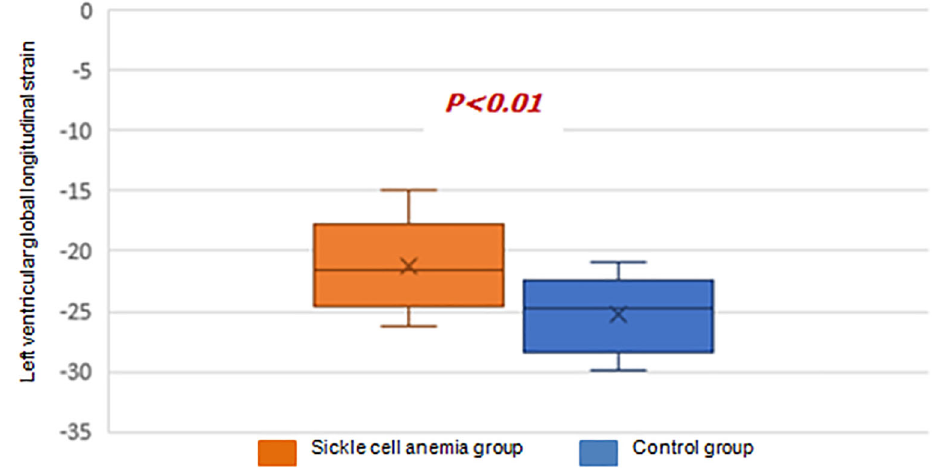
Figure 4. Comparison of the left ventricular global longitudinal strain in the two (cid:129) Study of longitudinal myocardial deformation using the speckle tracking technique Accordingtothisstudy,theoptimal cutoffvalueofGLSwas-21.3%(AUC 0.79,95%CI[0.68 – 0.90], p<0.001). The sensitivity, specificity, positive predictive value, and negative predictive value were 48%, 82%, 96%, and 65%, respectively, for predicting altered LV contractile function (Figure 3). In the SCA group, LVGLS was estimated at -21.2 (cid:1) 3%. It was significantly reduced (-20%) in 46% of the children (n=14), whereas it was significantly higher (-25.03 (cid:1) 2.9%) in the C group with no decreased value (Figure 4). (cid:129) Univariate and multivariate analyses of factors associated with abnormal LVGLS In the SCA group, impaired LVGLS was significantly associated with left ventricular mass (LVM), LV tele diastolic diameter, and left atrial volume (Table 4).